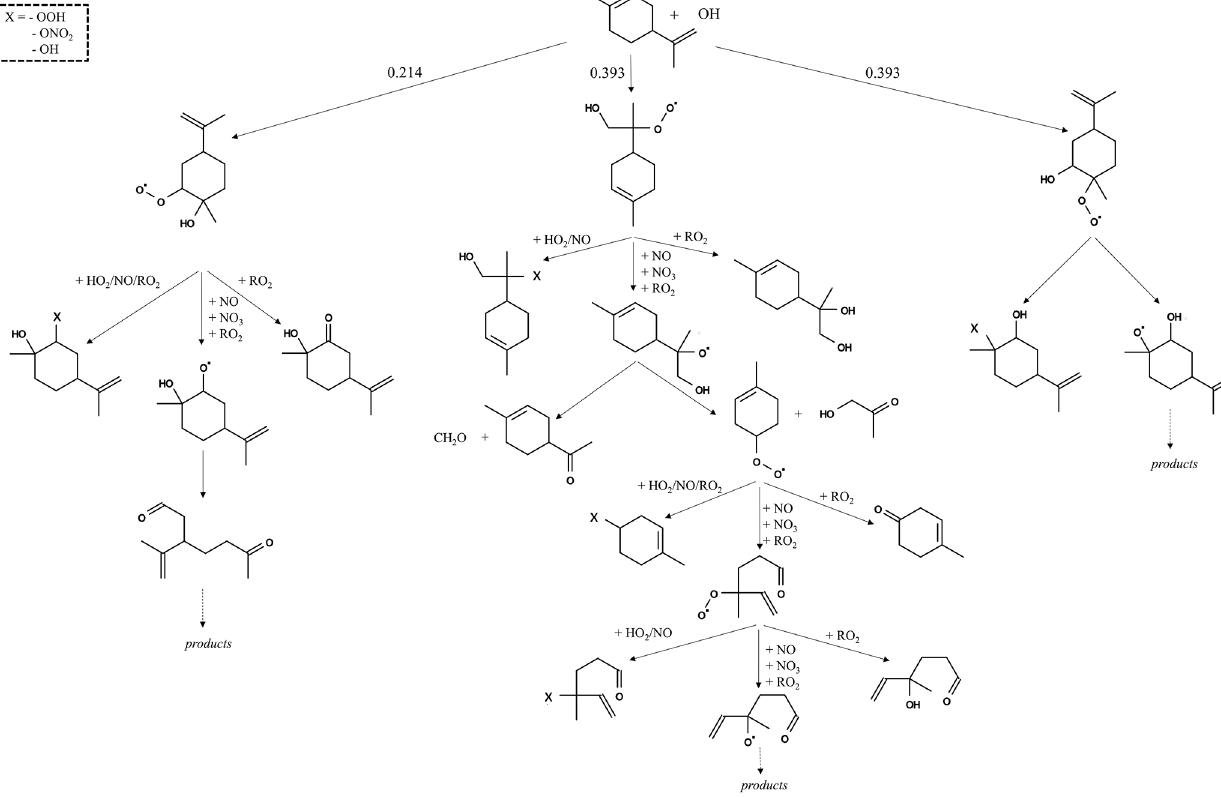
https://doi.org/10.5194/acp-21-11467-2021 Atmos. Chem. Phys., 21, 11467–11487,